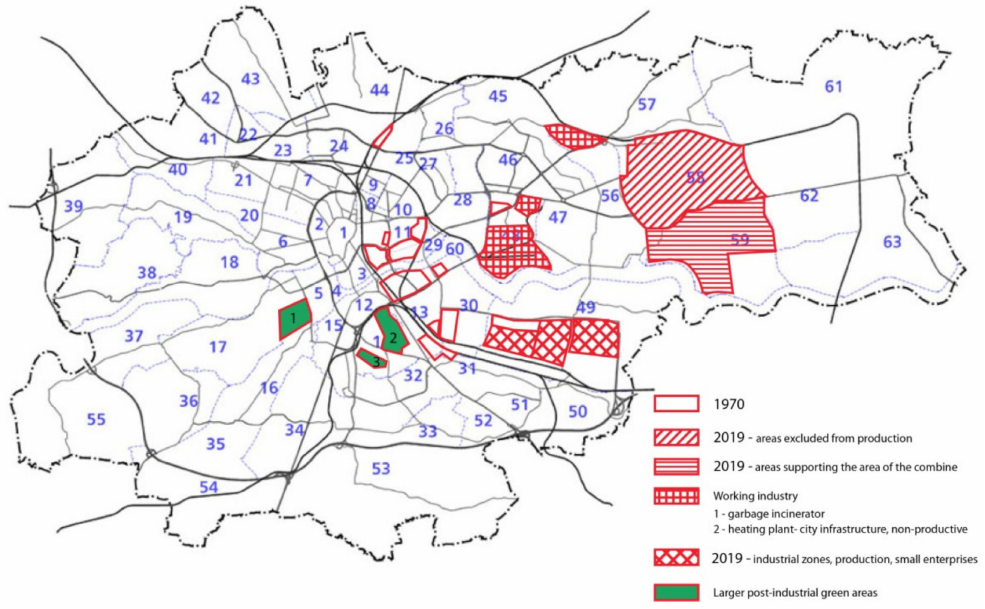
Figure 3. Spatial and functional changes in the field of industry functions in the last 50 years in Cracow.